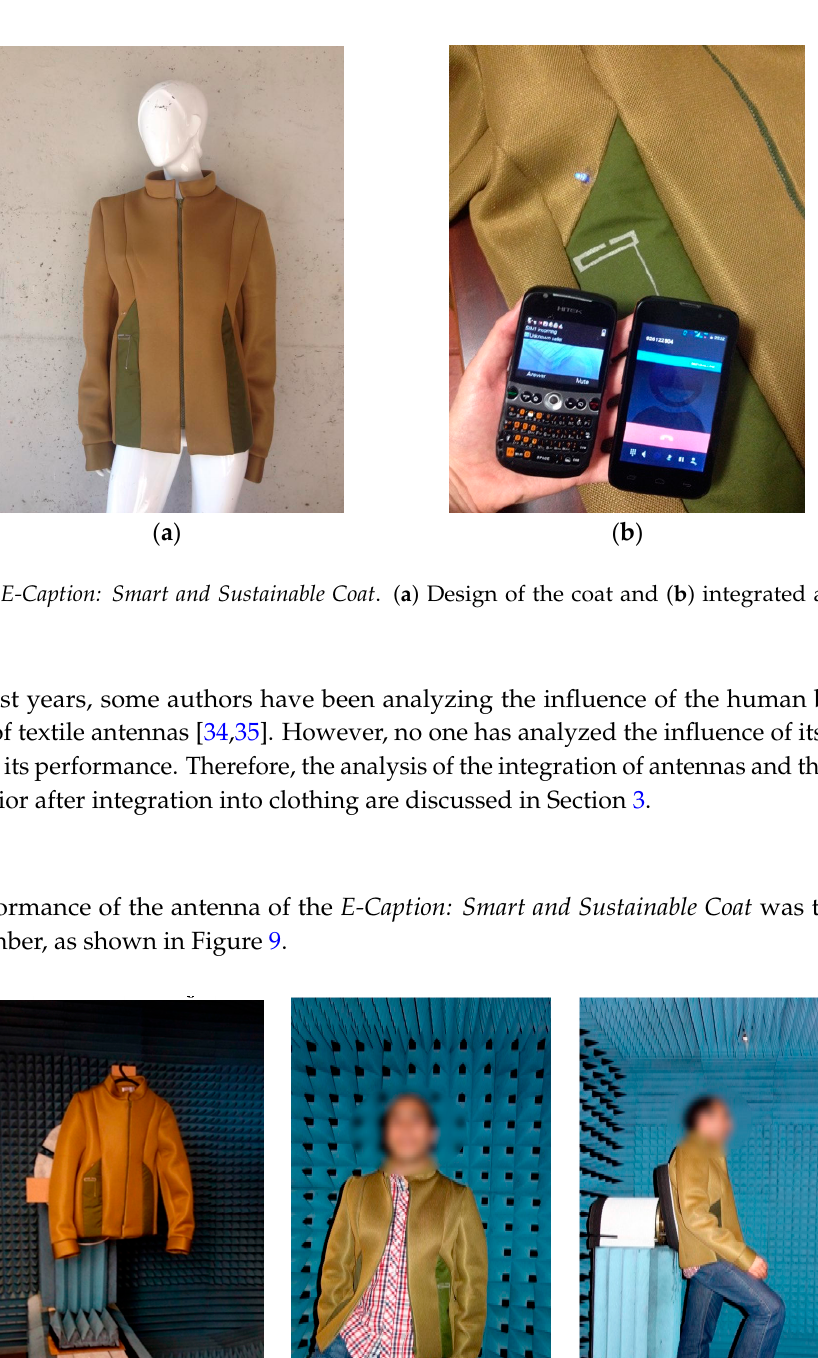
Figure 9. Performance of the antenna in the anechoic chamber ( a ) in free space and ( b , c ) on-body measurements.